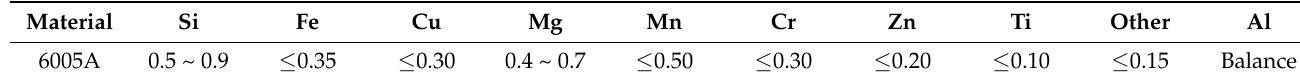
Figure 2. Engineering drawings of the test structural component (all dimensions are in mm).